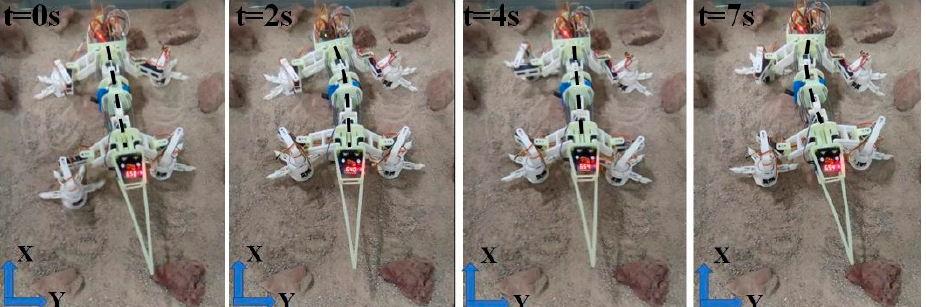
Figure 13. Grasping tests: ( a ) retrieving state and ( b ) grasping state.